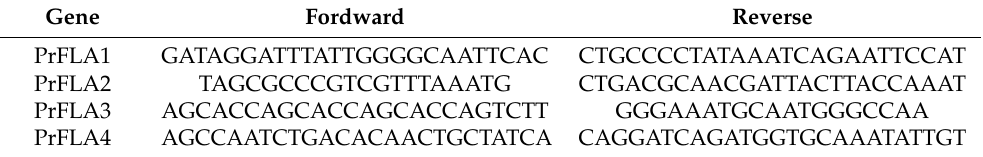
Table 2. Primer list.